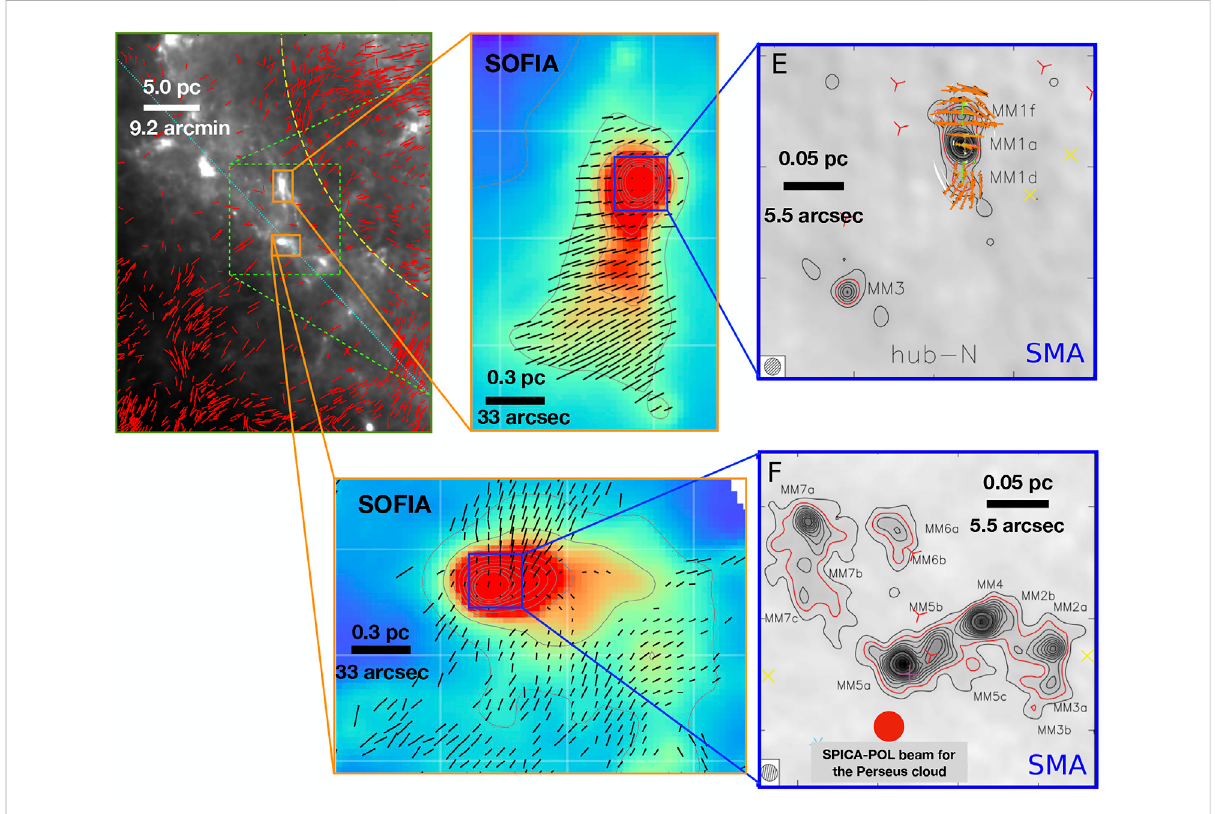
FIGURE 5 Composite images of the G14.225 – 0.506 massive star-forming region (Busquet et al., 2016; Santos et al., 2016). Top left panel: R band optical polarization vectors (red segments) overlaid on Herschel 250 μ m image overlapped (from Santos et al., 2016). Central panels: SOFIA/HAWC +200 μ m images(beam 14 ″ )of thenorthern (top) and southern (bottom) hubs, with blacksegments showingthe magnetic fi eld direction(F.Santos, private communication). Right panels: submillimeter array (SMA) images of the 1.2 mm emission toward the center of the northern (top) and southern (bottom) hubs (Busquet et al., 2016), with orange segments showing the magnetic fi eld direction (Añez et al. in